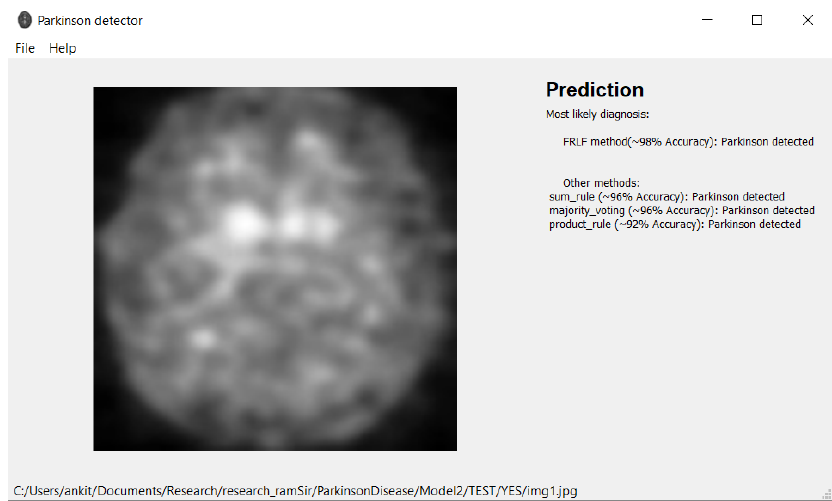
Figure 13. Illustration of prediction made by the software tool while classifying the DaTscan image as “PD”